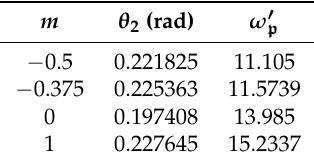
Table 3. Cavitation angles θ 2 and the normal forces ω (cid:48) p , computed for m = − 0.5, − 0.375,0,1 when (cid:101) = 0.1.